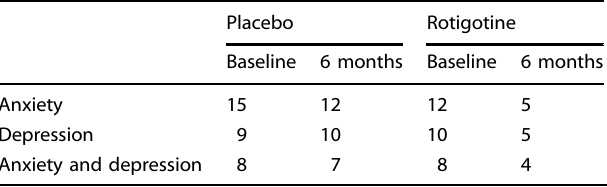
Table 2. Number of apathetic patients with anxiety state, depression state or both measured with a score of the dedicated item of the Ardouin scale of behavior in PD ≥